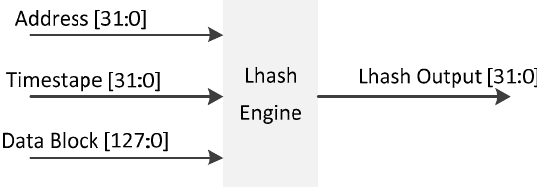
Figure 4. The inputs and output of the Lhash Engine.